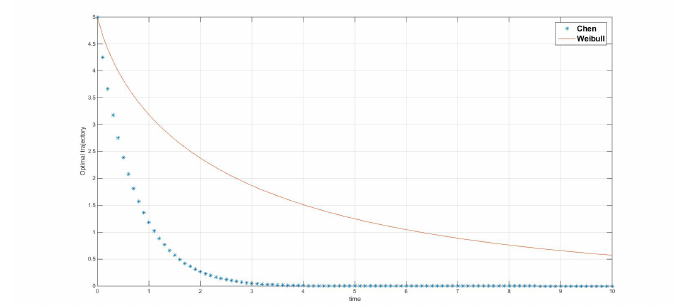
Figure 10. Optimal trajectories for laws of Weibull (continuous-red) and Chen (dotted-blue) when = δ = 1 = λ δ 1 = 1 2 and λ 1 2 . 2